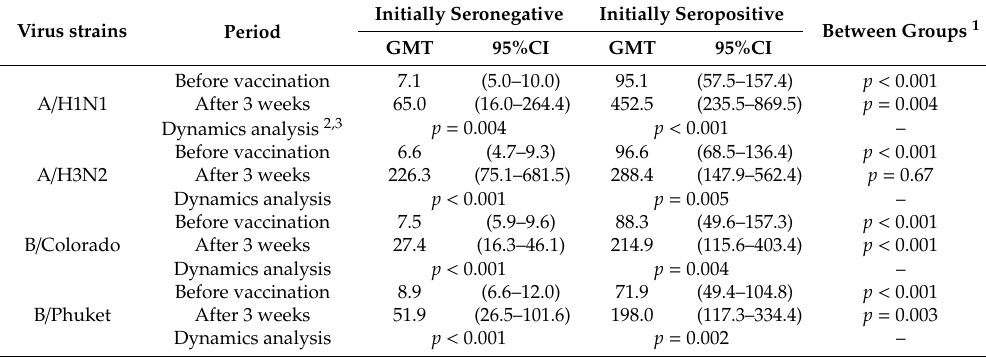
Table 4. GMT in the group of healthy participants given the initial level of antibodies.